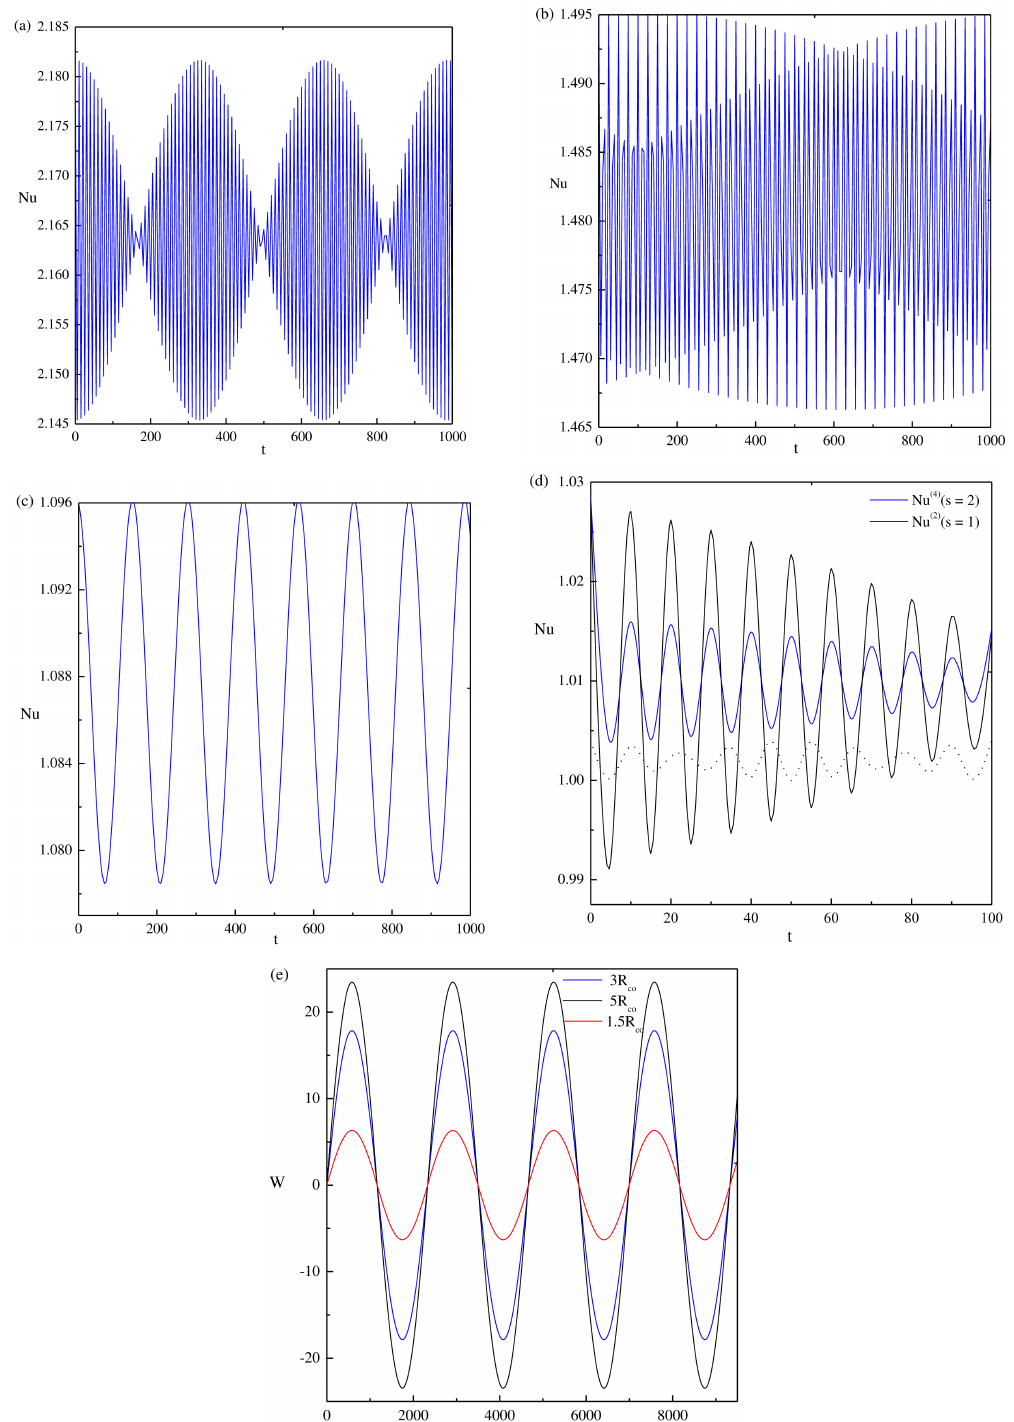
Figure 6. Dependence of Nu on t with Le = 0.04 and χ = 0.2 for ( a ) R = 42.4120727, ψ = − 0.03, ( b ) R = 41.9373585, ψ = − 0.02, ( c ) R = 41.5137494, ψ = − 0.01 and ( d ) Comparison of present work with numerical results: Dotted lines represent numerical values obtained by Brand and Steiberg [9] and solid curves represent analytical results of present work. ( e ) Measurement of the vertical component of the velocity ( W ) for different R with X = 0.5, Z = 0.5, ψ = −